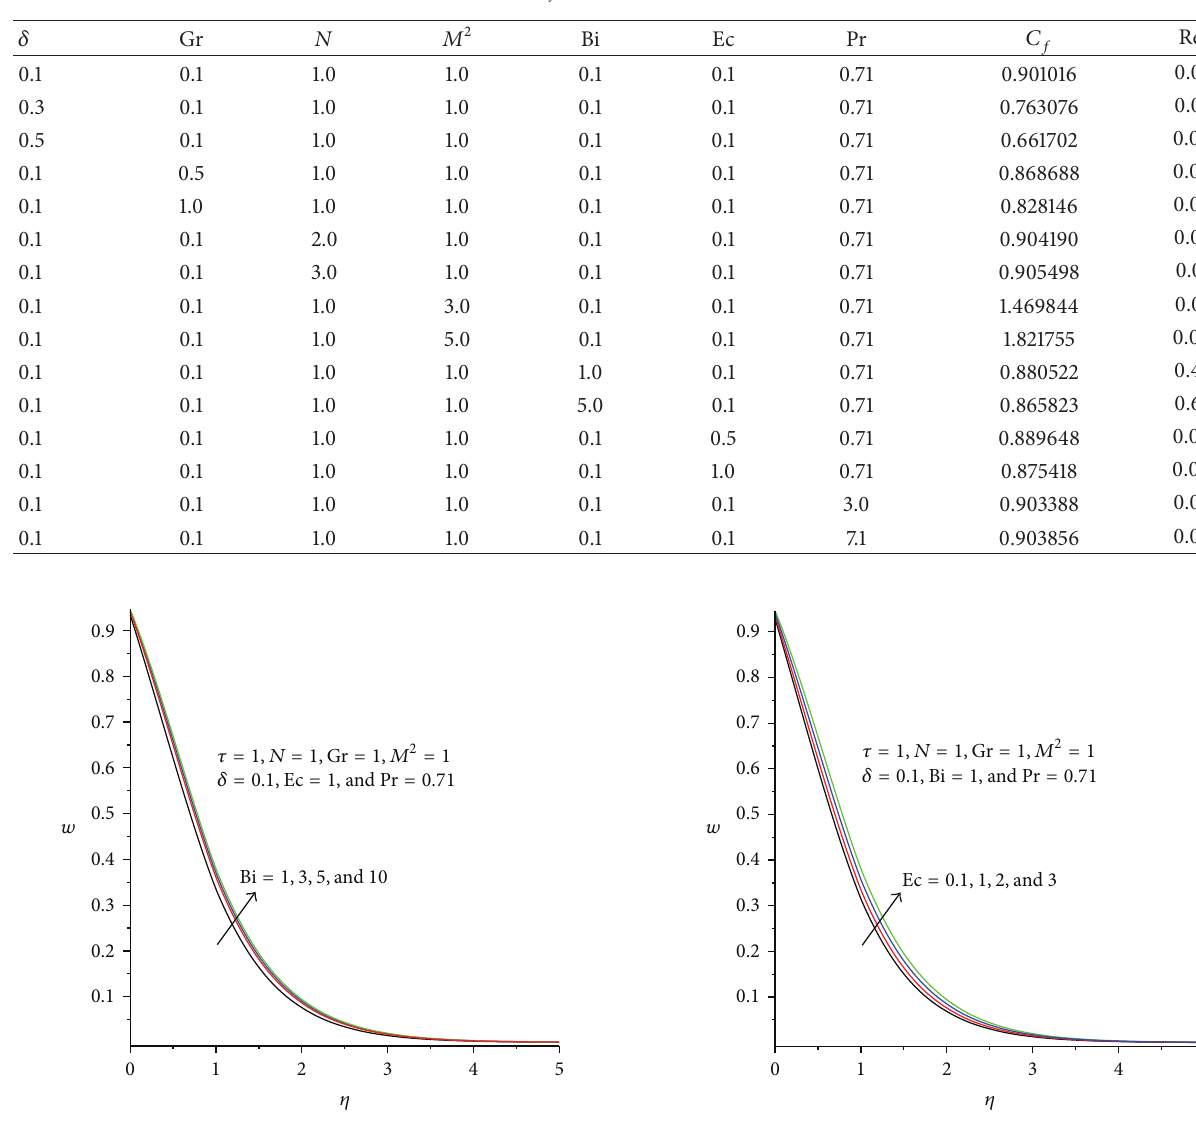
Table 1: Computation showing the 𝐶 𝑓 and Re −1 𝑥 Nu for various values of embedded parameter.